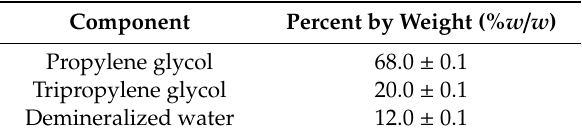
Table 2. SAE AS5900 High speed ramp reference fluid